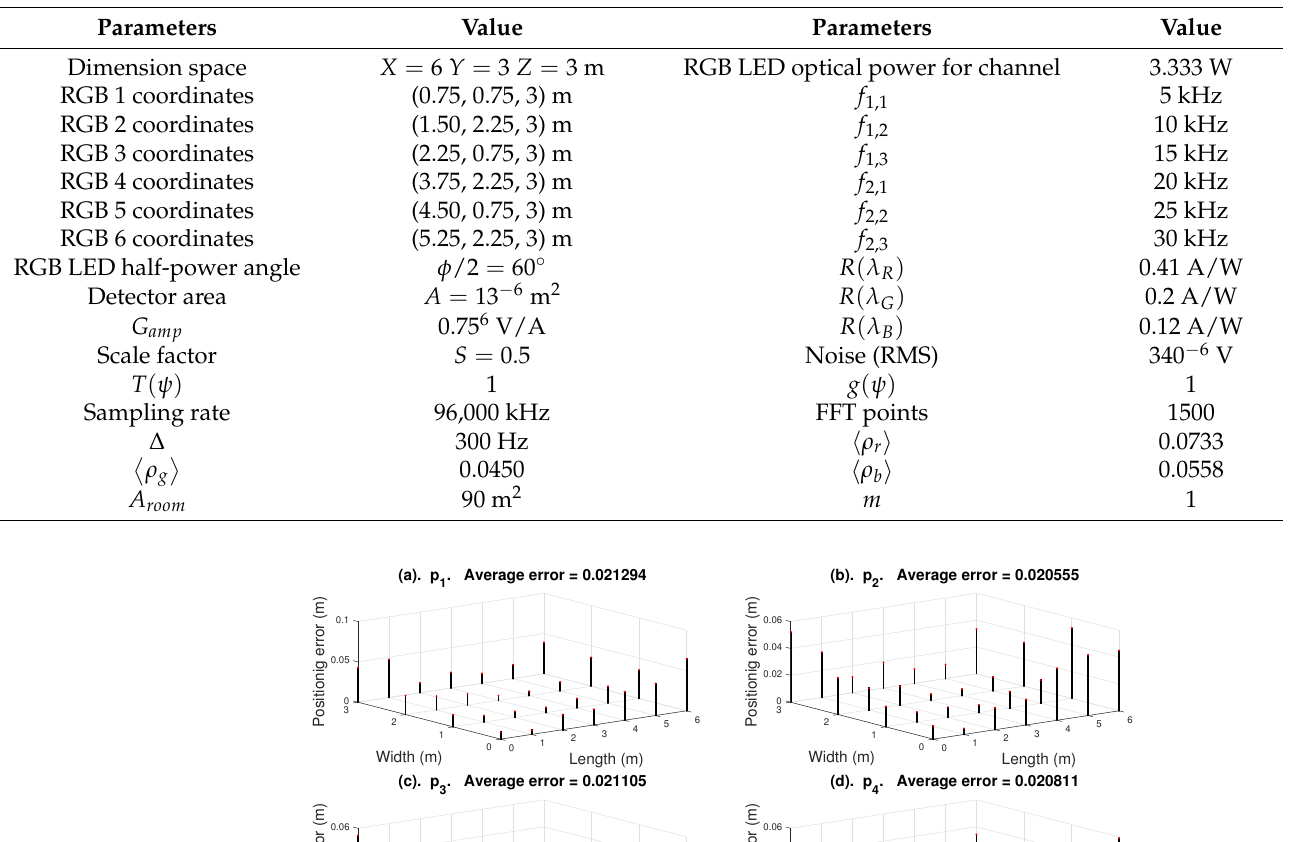
Table 2. Simulation parameters.